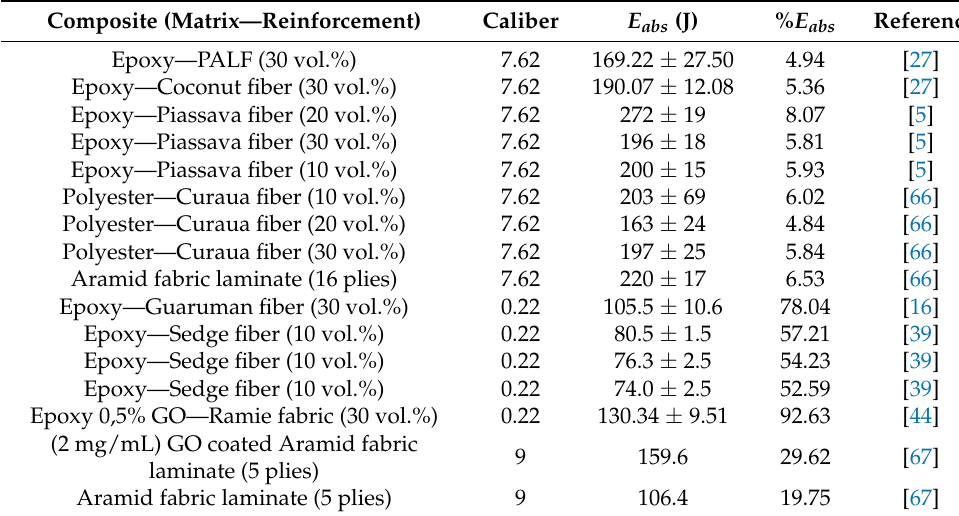
Table 6. Absorbed energy values from composites in the